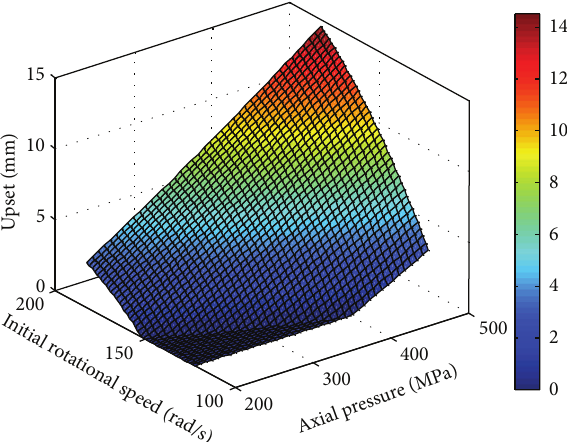
Figure 7: Surface plot of prediction results by RBF